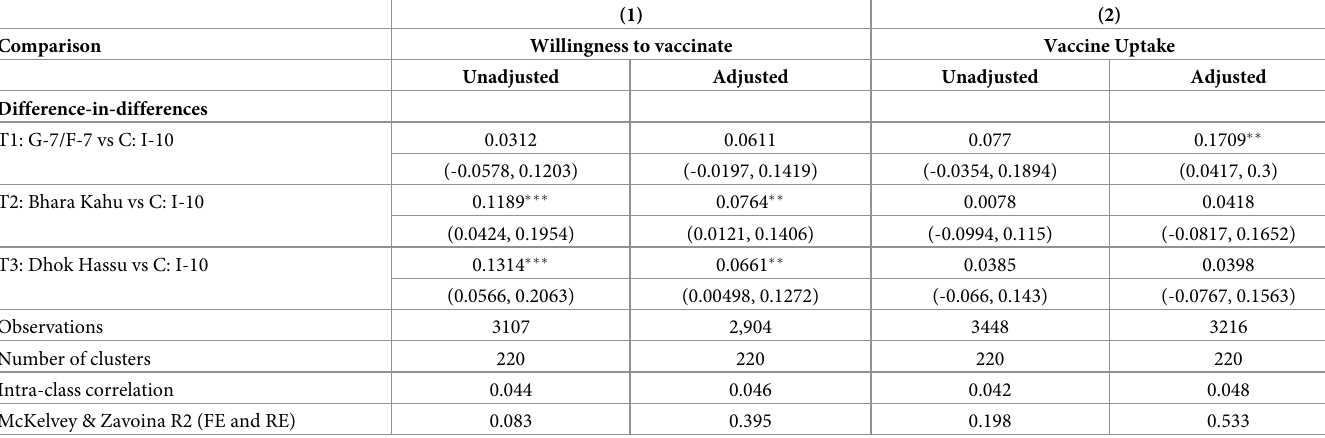
Table 4. Pairwise comparisons of average marginal treatment